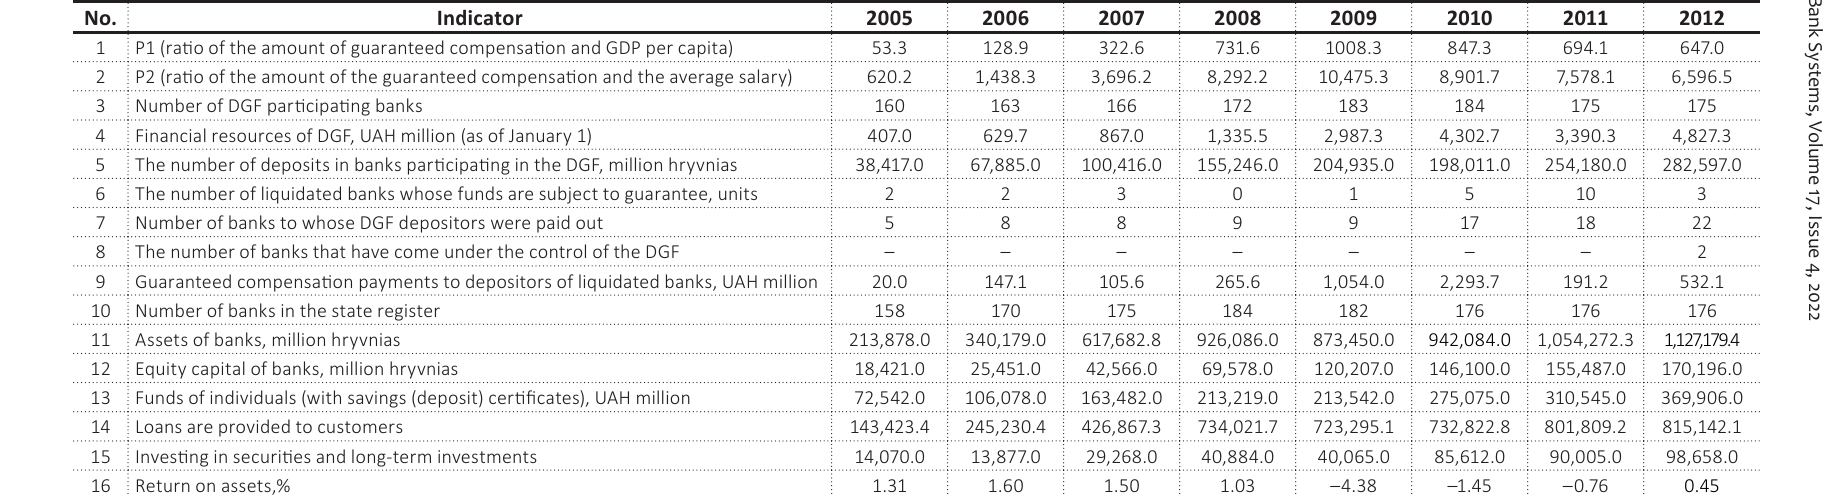
Table А1. Deposit insurance indicators in Ukraine in 2005–2012 No.